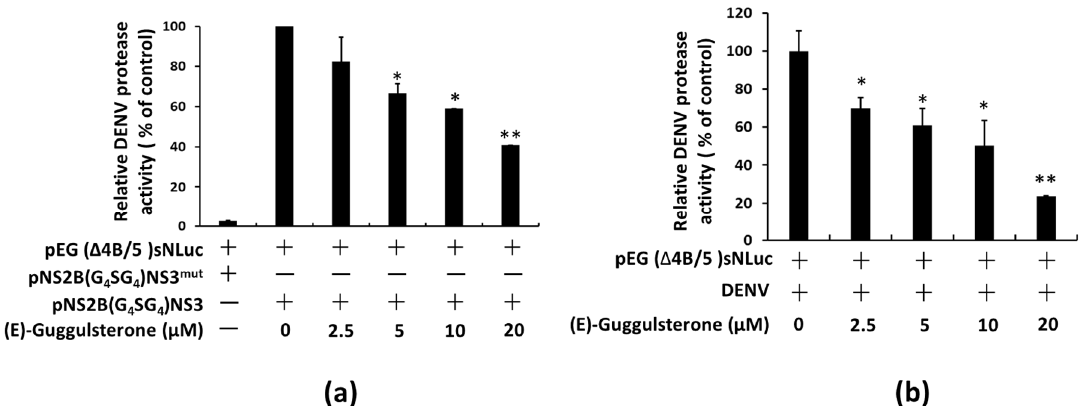
Figure 4. (E)-Guggulsterone inhibits DENV NS2B/NS3 protease activity. ( a ) Huh-7 cells were co-transfected with the protease reporter vector, pEG ( ∆ 4B/5) sNLuc, and the protease expression vector, pNS2B (G4SG4) NS3, or the mutant protease expression vector, pNS2B (G4SG4) NS3mut. ( b ) DENV infected Huh-7 cells were transfected with the protease reporter vector. The plasmid-transfected cells were treated with (E)-guggulsterone at the indicated concentrations for 3 days. DENV NS2B/NS3 protease activity was measured by detecting the secreted nano-luciferase activity in the supernatant. Each transfection mixture contained 0.1 μ g of the firefly luciferase expression vector as a transfection control for normalization against the nano-luciferase activity. The relative percent inhibition was compared to protease-expressing or DENV-infected cells, defined as 100%. The results are expressed as the mean ± SD (error bar) of three independent experiments ( n = 3); * p < 0.05, ** p < 0.01.